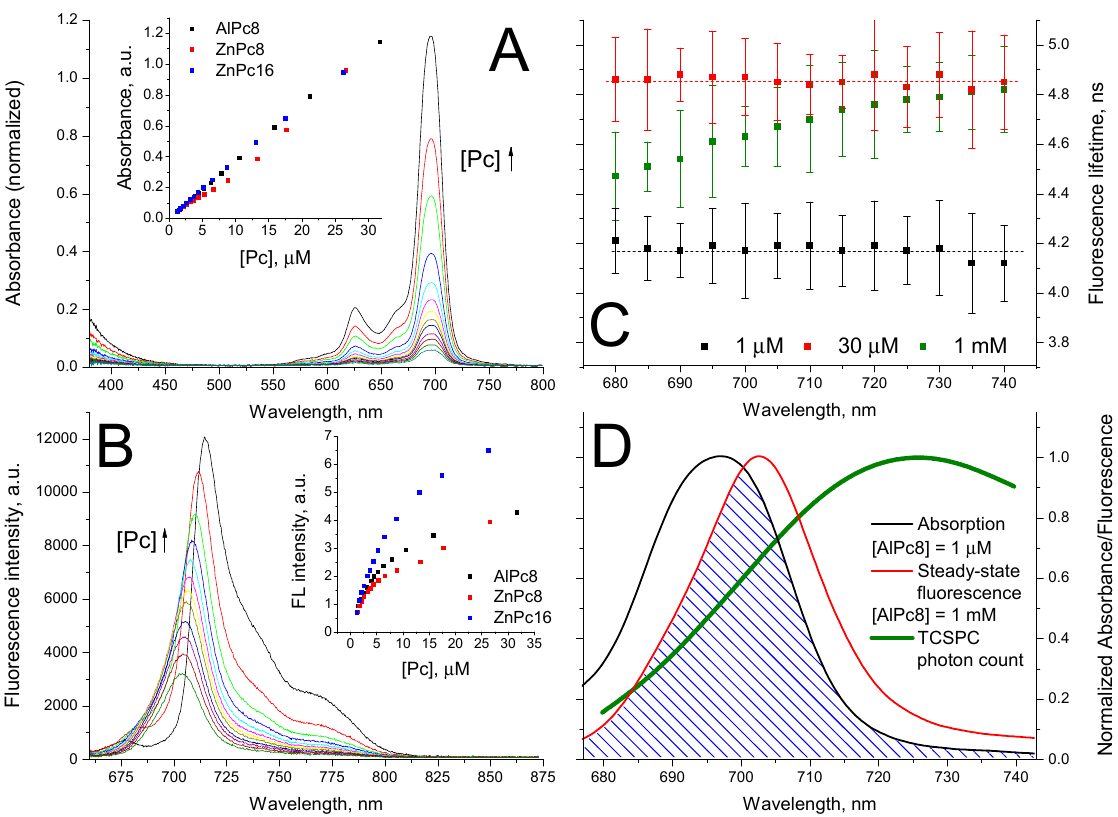
Figure 2. ( A ) Absorption spectra of AlPc8 in the concentration range 1–30 µ M. The inset shows the concentration dependences of the absorbance of carboxyphthalocyanines at the wavelength of the Q I band position. ( B ) Fluorescence spectra of AlPc8 in the concentration range 1–30 µ M. The inset shows the concentration dependences of the integral fluorescence of carboxyphthalocyanines. The fluorescence was excited at 655 nm. ( C ) The average fluorescence lifetime of AlPc8 in a cuvette with a 1 µ M solution, as well as in a capillary with a 30 µ M and 1 mM solution. The fluorescence excitation wavelength is 405 nm. ( D ) Normalized absorption spectrum and fluorescence spectra of AlPc8 measured in dilute and concentrated solution.